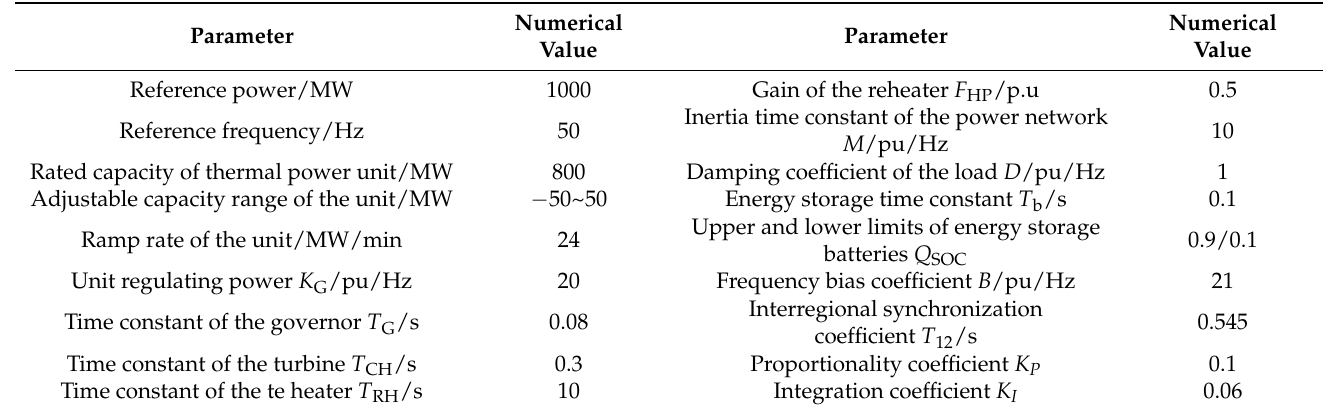
Table 1. Simulation model